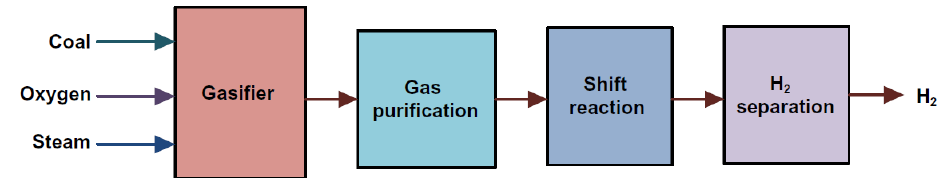
Figure 2. Hydrogen production by the coal gasification process [8]. Reprinted with permission from Elsevier.